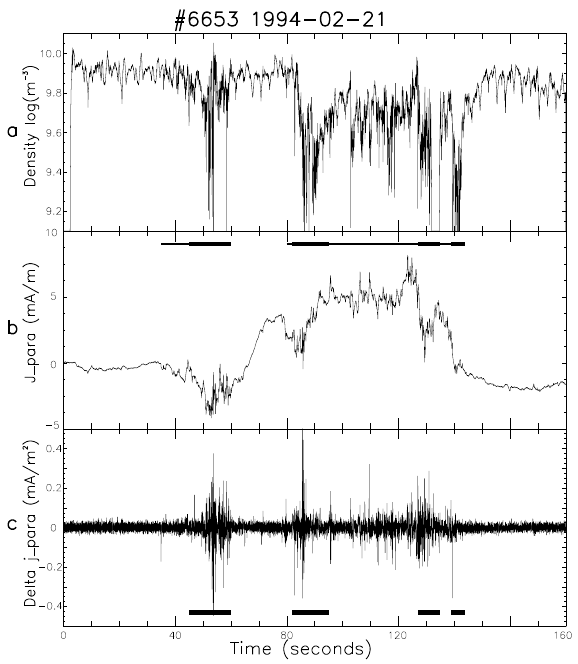
Fig. 5. The plasma density estimated from the Langmuir probe mea- surements (panel a) together with the estimated field-aligned current density assuming the Freja spacecraft encounters spatial structures (panel c), and the corresponding integrated net current (panel b). Alfv´en wave activity results in localized regions with rather small net integrated currents on top of larger scale current systems. The thick horizontal lines in panels (b) and (c) represent where signifi- cant density drops can be found, panel (a) (note a probe sweep at + 0 and + 132seconds). The thin horizontal lines, panel (b), represent where DAW is seen.